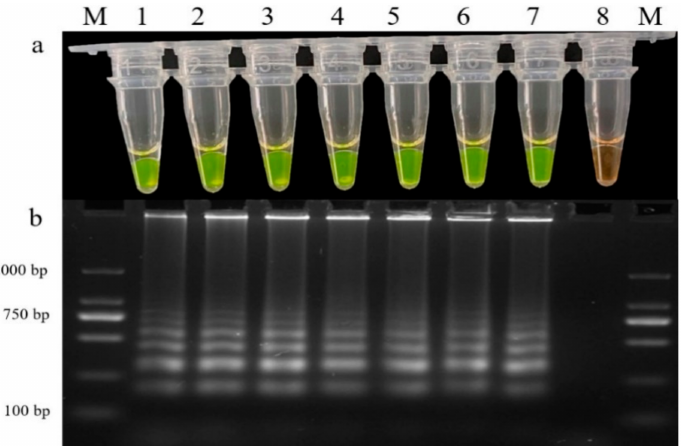
Figure 3. Profiles of LAMP reactions for P. graminea with serial concentrations of dNTPs. Assess- ments of LAMP products based on SYBR Green I visualization of color change ( a ) or agarose gel electrophoresis ( b ). Lane M, DNA ladder; tubes and lanes 1 to 7, LAMP reaction with dNTP con- centrations of 0.6, 0.8, 1.0, 1.2, 1.4, 1.6, and 1.8 mM, respectively; tube and lane 8, negative control with ddH 2 O.